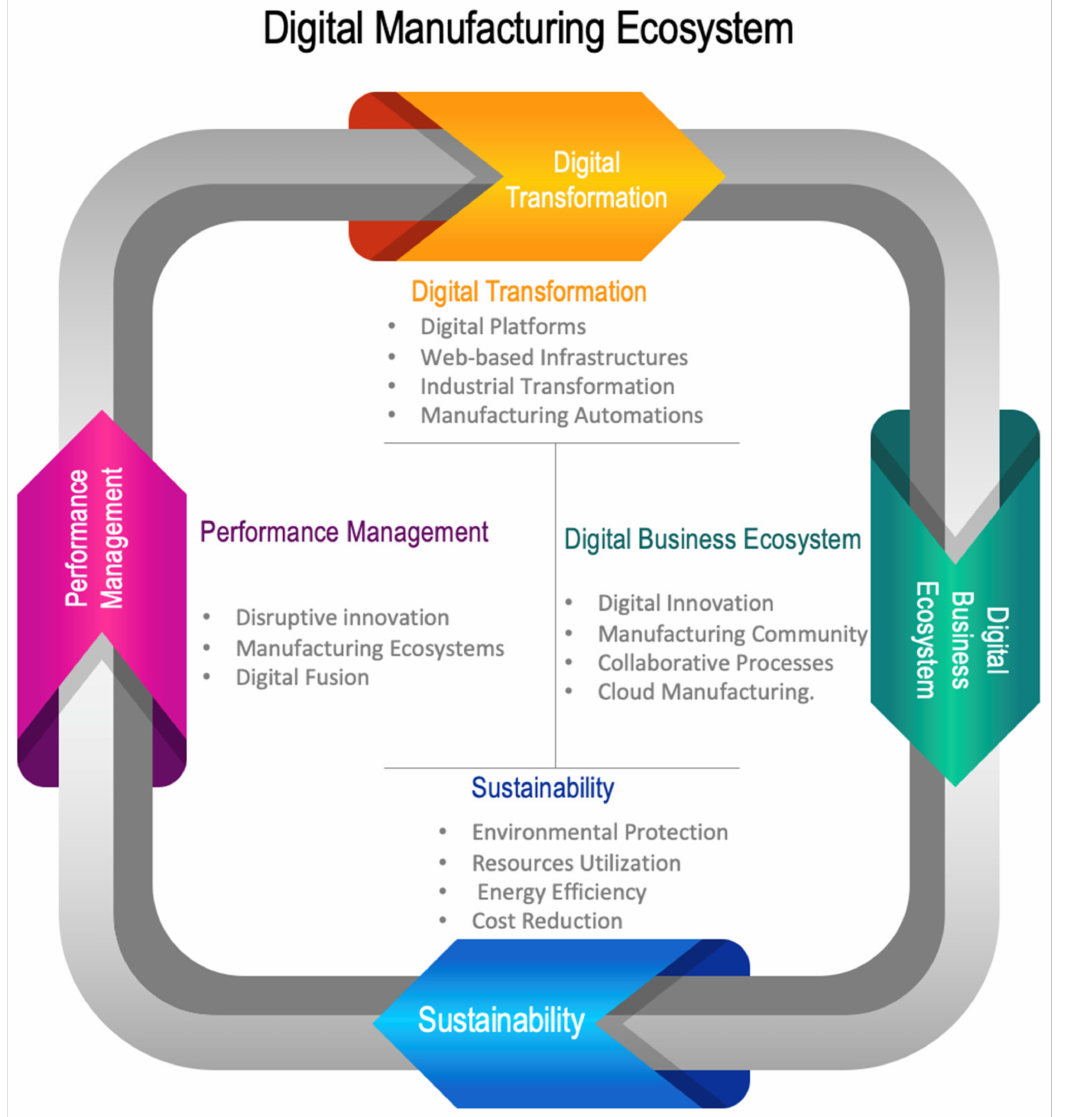
Figure 7. The outcomes of literature on the digital manufacturing